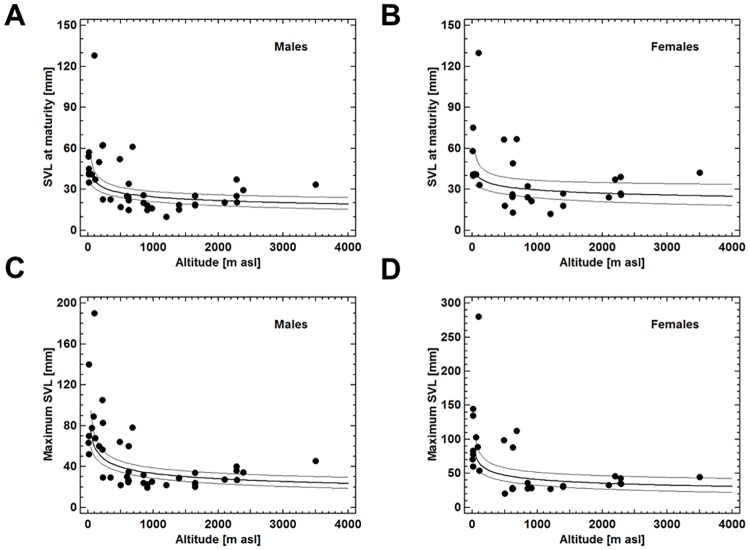
Multiplicative regression models describing the association between the size-related life-history traits and altitude, the only environmental variable explaining a significant amount of variance.Statistical details are given in the text. Each dot represents a distinct species of tropical anurans.